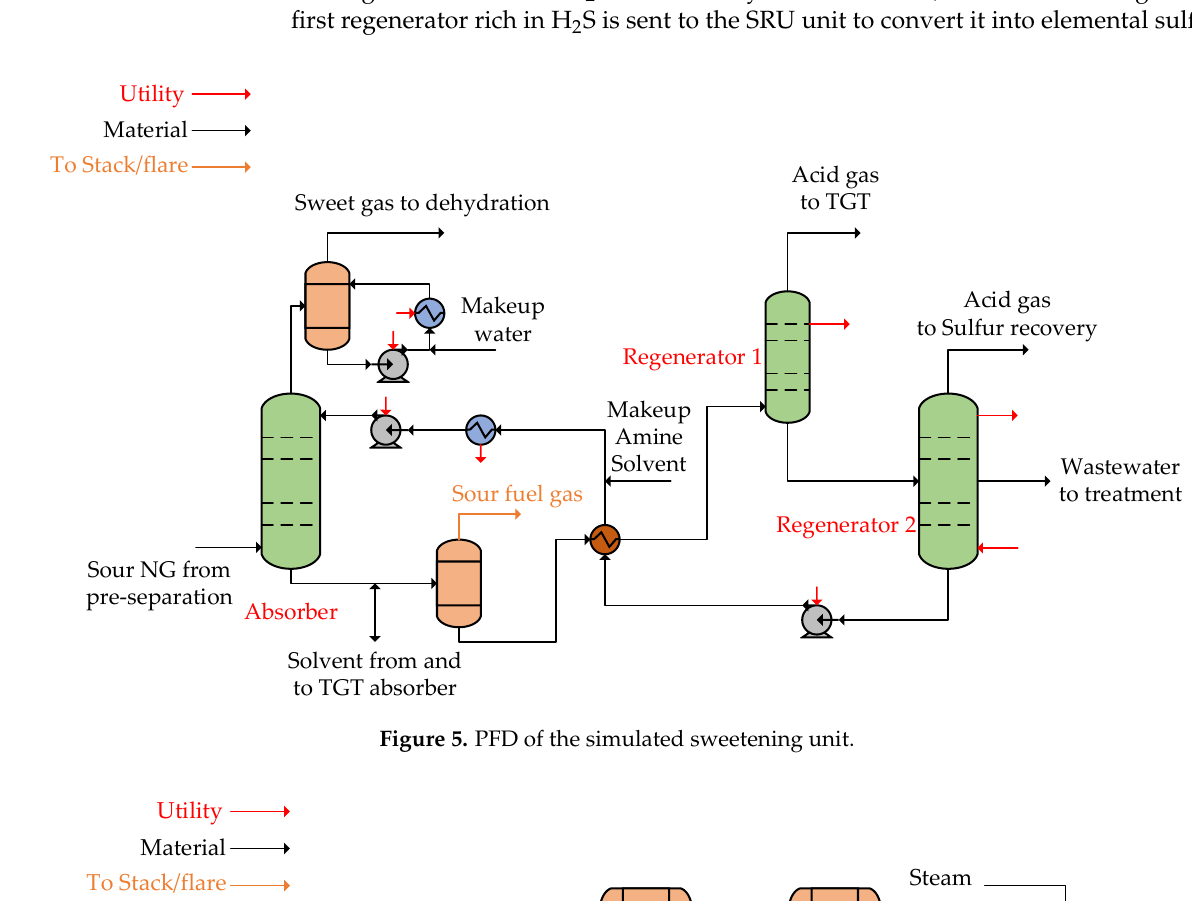
Table 5. SRU and TGT conditions and specifications.